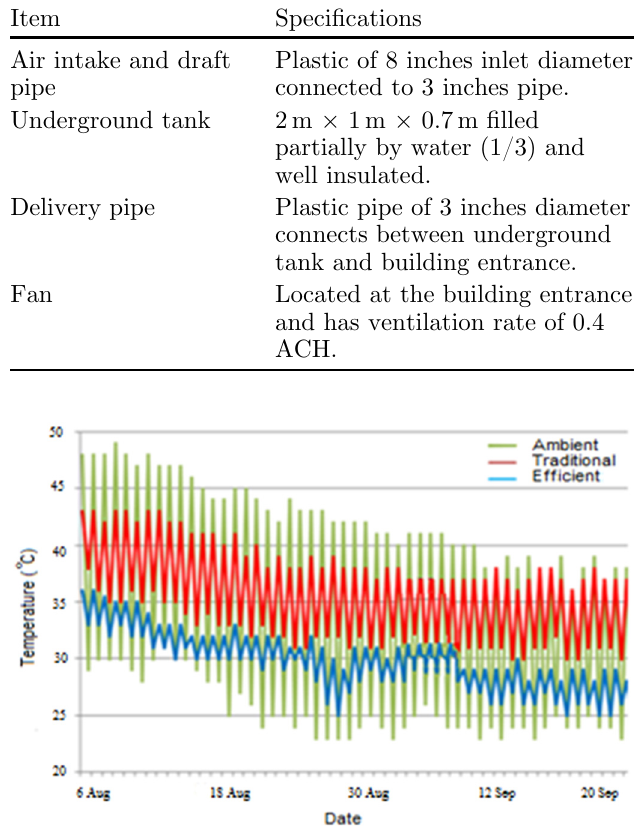
Fig. 3. Variation of indoor and outdoor temperatures during summer